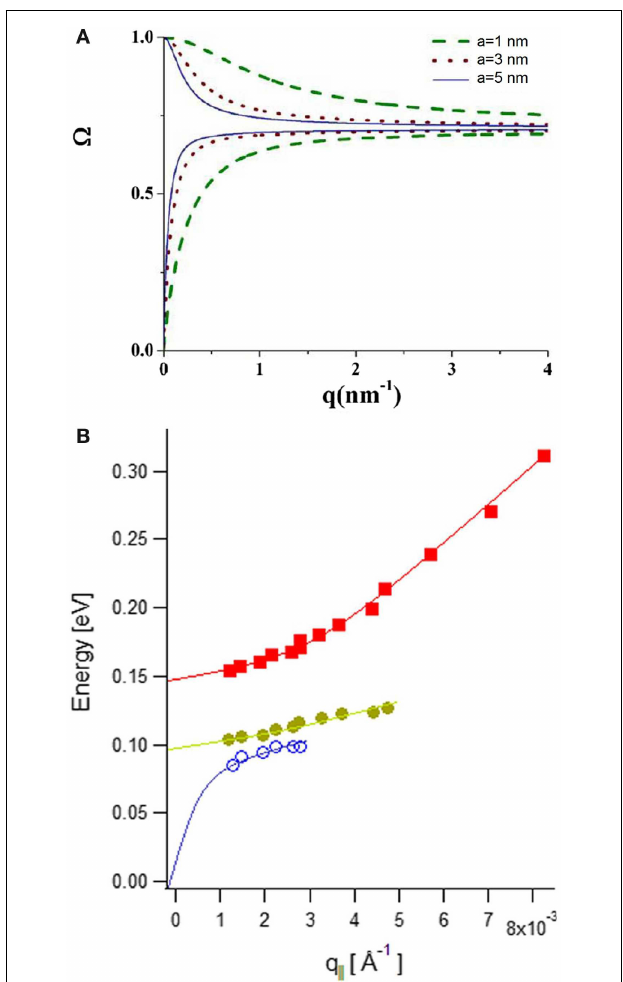
FIGURE 1 | (A) Effects of thickness on the solution of the Eq. 1 for plasmon frequencies in thin films of thickness a . Adapted from Ali and Elham (2013); (B) Plasmon dispersion in graphene on SiO 2 .The interaction of optical phonons of SiO 2 with plasmons modifies the dispersion calculated following Eq. 1. Adapted fromYan et al.